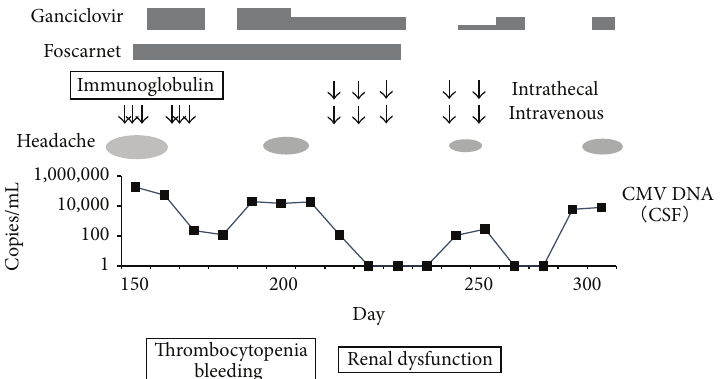
Figure 1: Clinical course of patient. Day means day from second cord blood transplantation. CMV: cytomegalovirus, CSF: cerebrospinal